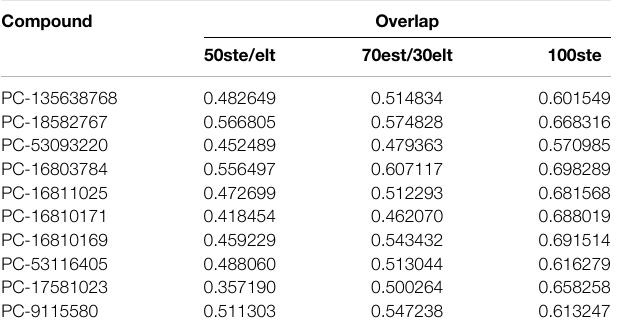
TABLE 11 | Overlap similarity values of the 10 promising compounds in relation to Roc-A. Compound